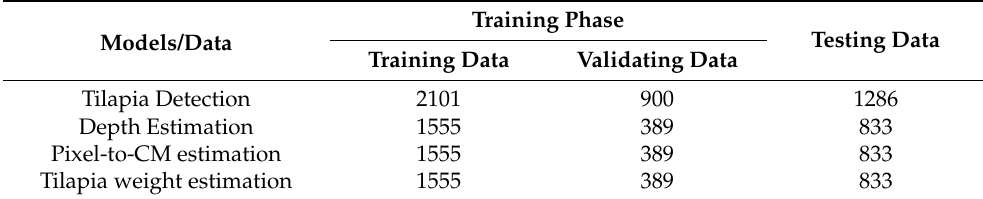
Table 2. The number of training and testing